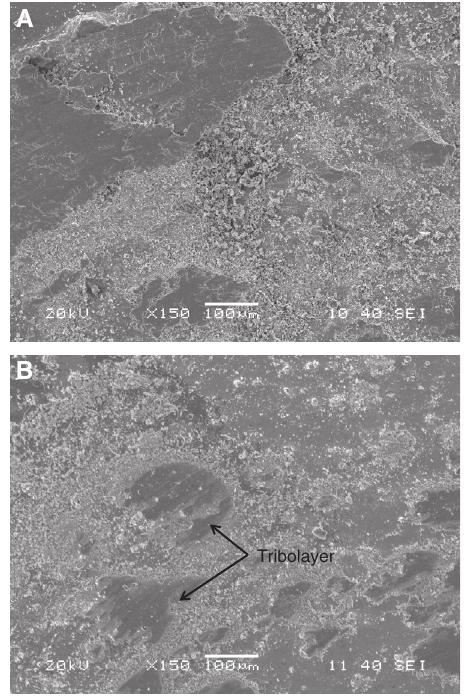
Figure 8: SEM micrographs of the worn surfaces showing wear track of Cu-5 vol.% Al O (A) nanocomposite and (B) microcomposite 2 3 indicating wear